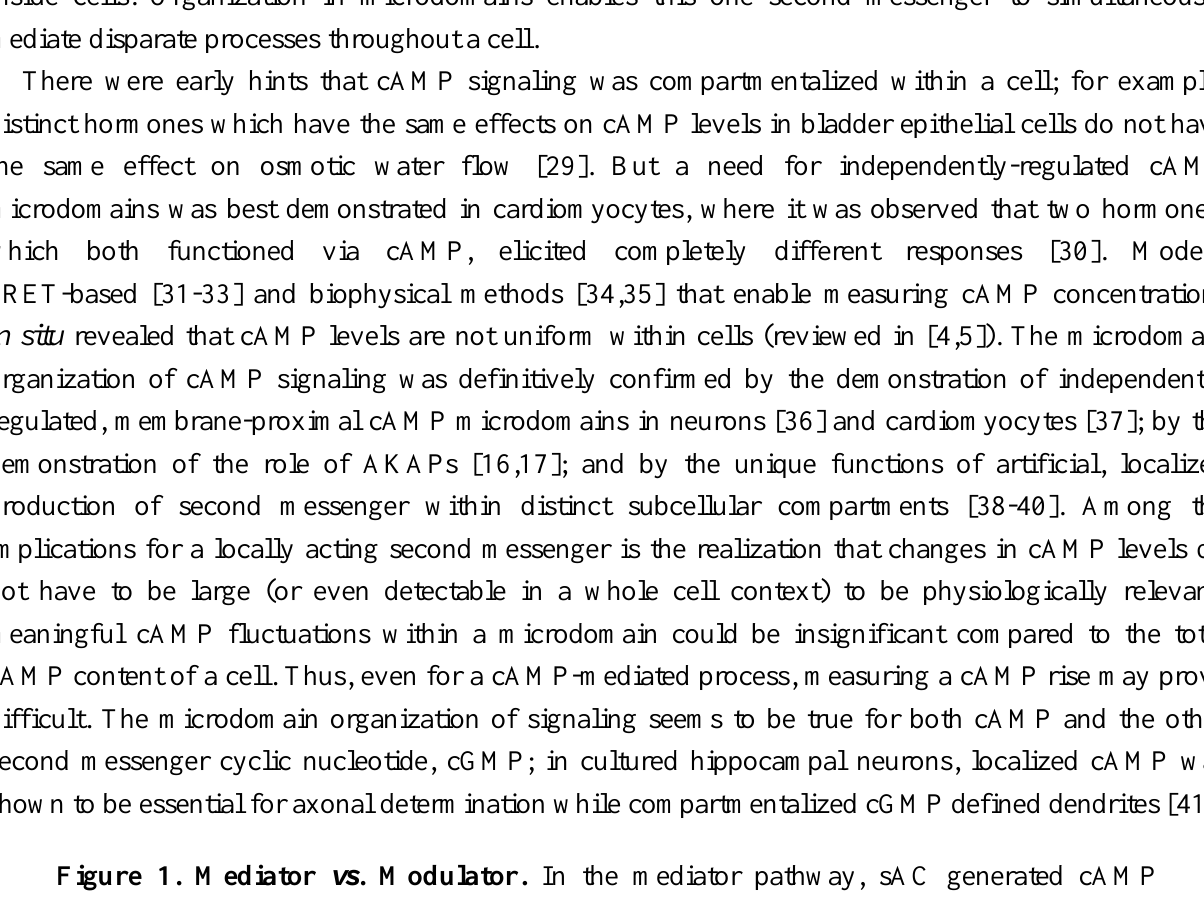
Figure 1. Mediator vs . Modulator. In the mediator pathway, sAC generated